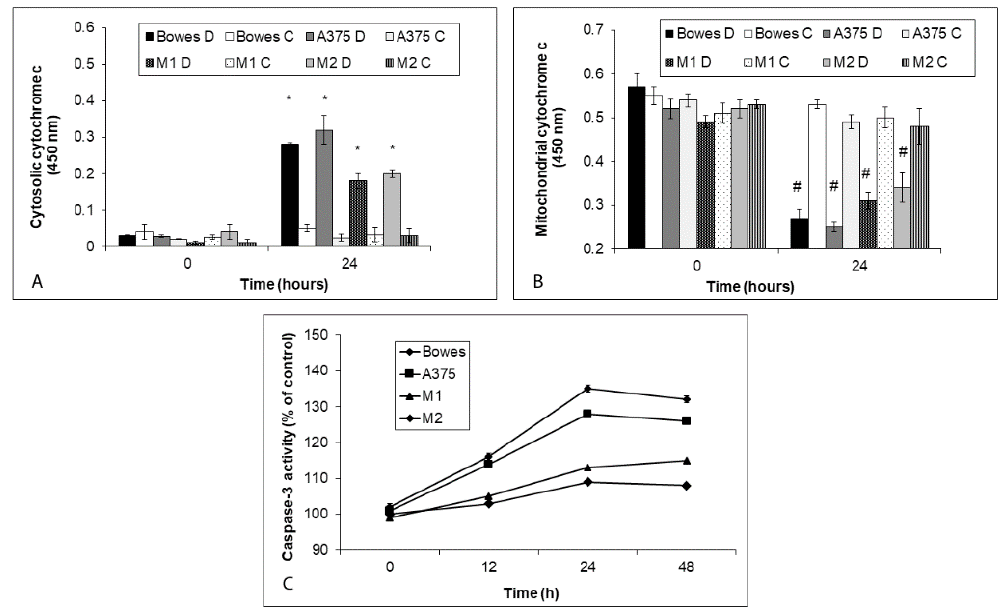
Figure 7. Cytoplasmic translocation of mitochondrial cytochrome c and activation of caspase-3 in